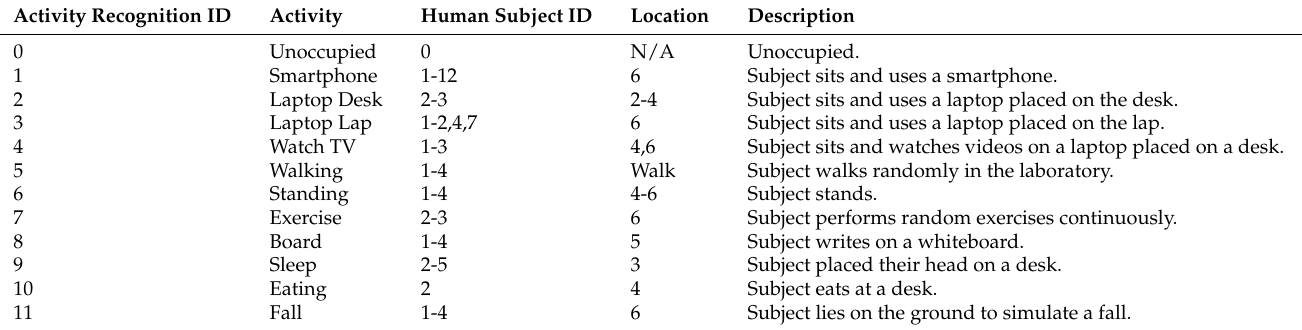
Table 1. Data collection table including activity, human subject, location, and